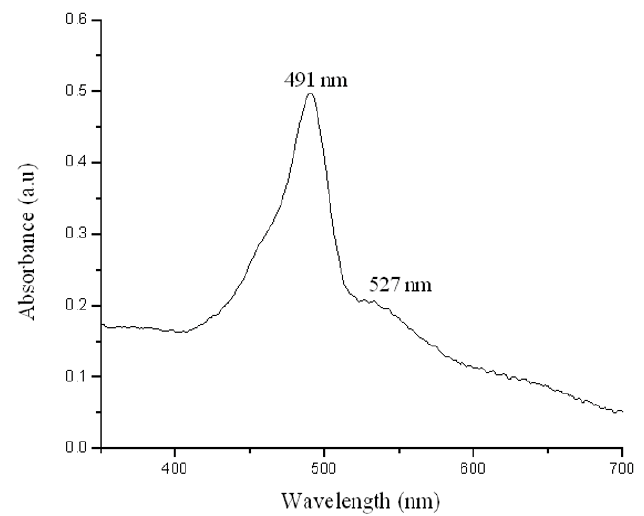
Figure 6. Absorbance plot for AuNPs-FI.